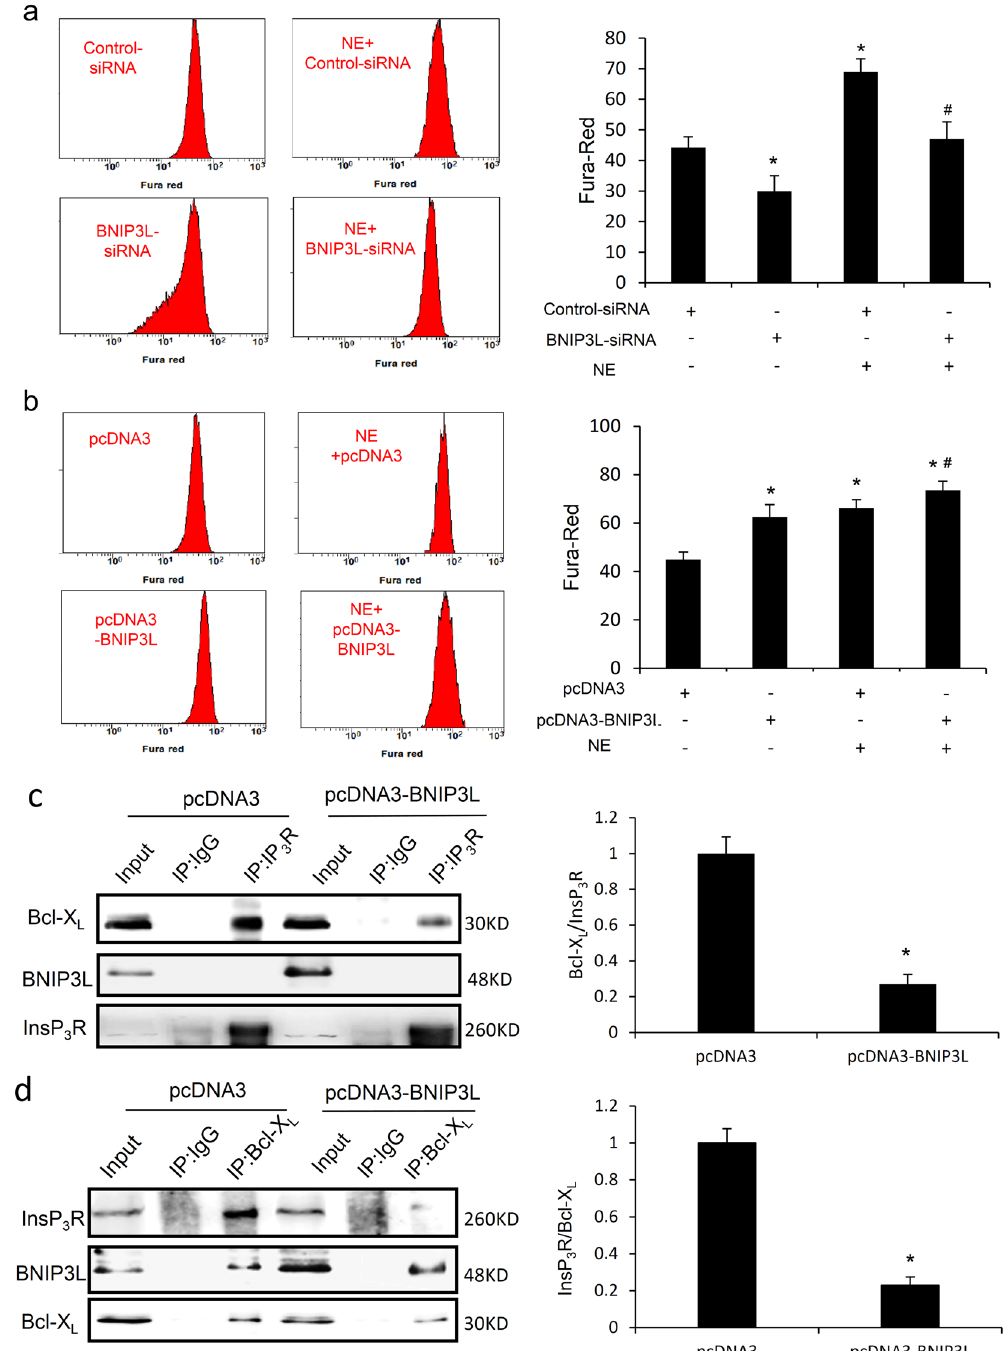
Figure 7. BNIP3L regulates Ca 2 + in CFs. Neonatal rat CFs were loaded with Fura Red and analyzed by flow cytometry. Data are reported as fluorescence intensities. ( a ) The BNIP3L-siRNA transfected or NE-induced cells were loaded with Fura Red and analyzed as above ( * P < 0.05 vs. Control, # P < 0.05 vs. NE.). ( b ) The adenoviruses of BNIP3L-transfected or NE-induced cells were loaded with Fura Red and and analyzed as above ( * P < 0.05 vs. Control, # P < 0.05 vs. NE). ( c ) Co-immunoprecipitation showed the interaction of InsP 3 R with Bcl-X L and BNIP3L when the cells were transfected with pcDNA3-BNIP3L ( * P < 0.05 vs. pcDNA3). ( d ) Co-immunoprecipitation showed the interaction of Bcl-X L with InsP 3 R and BNIP3L when the cells were transfected with pcDNA3-BNIP3L ( * P < 0.05 vs. pcDNA3). Each experiment repeated three times. Data shown are mean ±